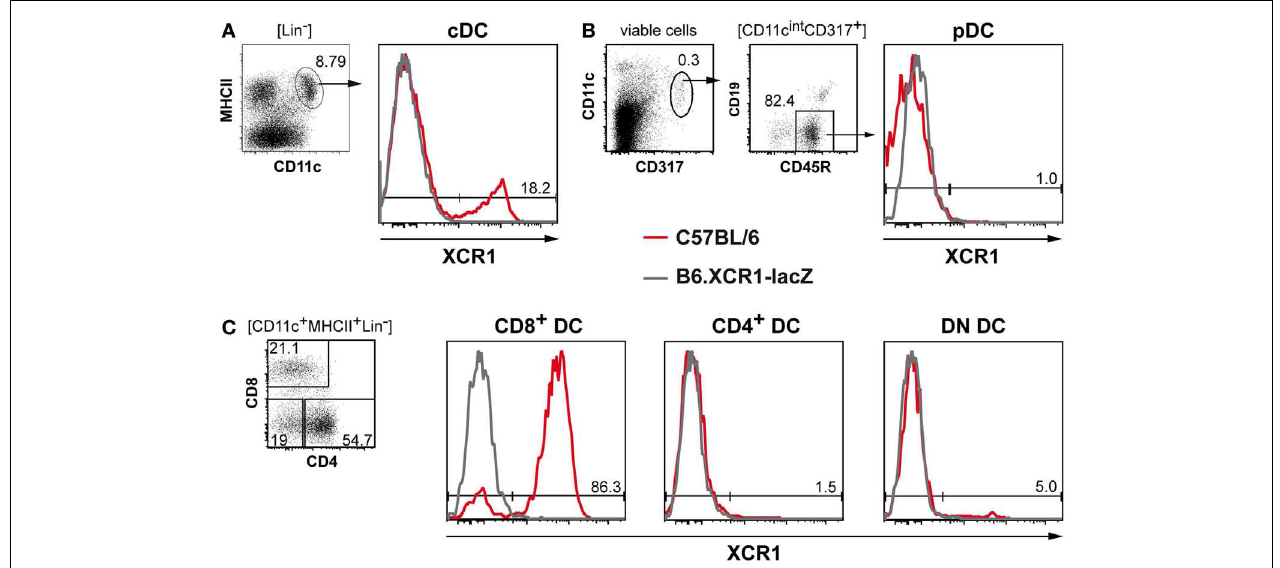
MARX10 and gated on (A) cDCs, (B) pDCs, or (C) the cDC subsets CD8 + , CD4 + , and DN DCs. Shown are results representative of at least three